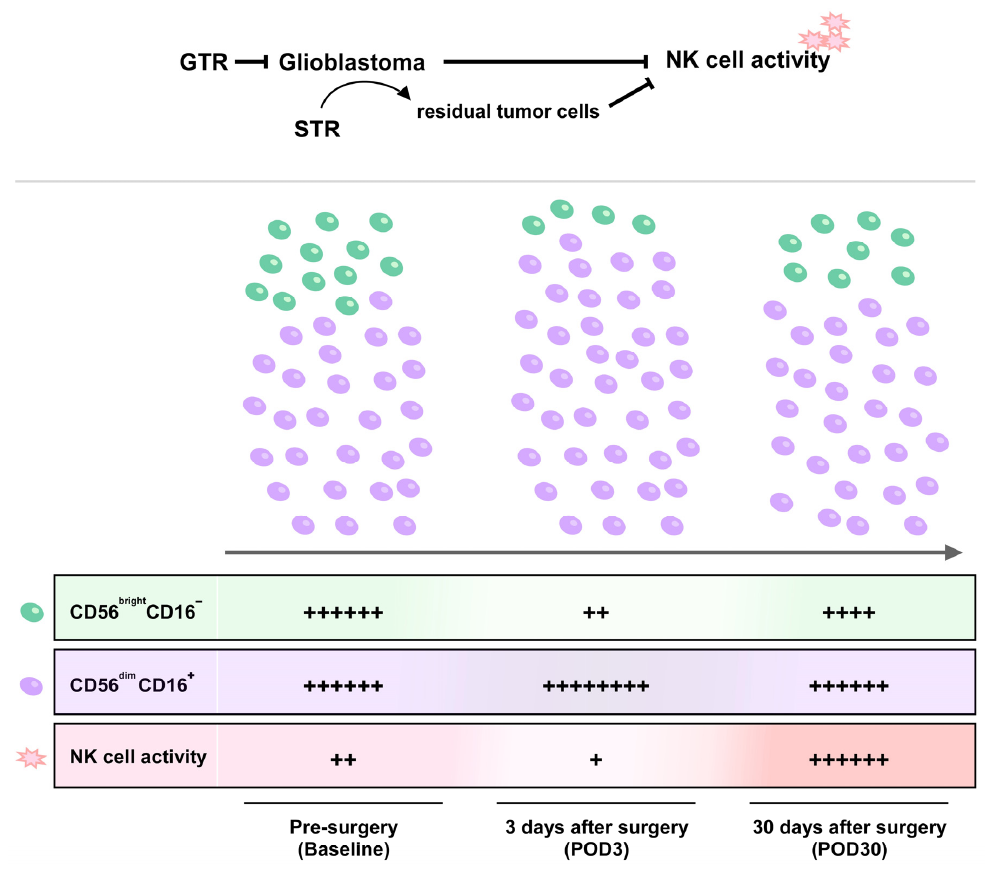
Figure 4. Schematic illustration of GTR in the recovery of the glioblastoma-suppressed natural killer cell activity with further